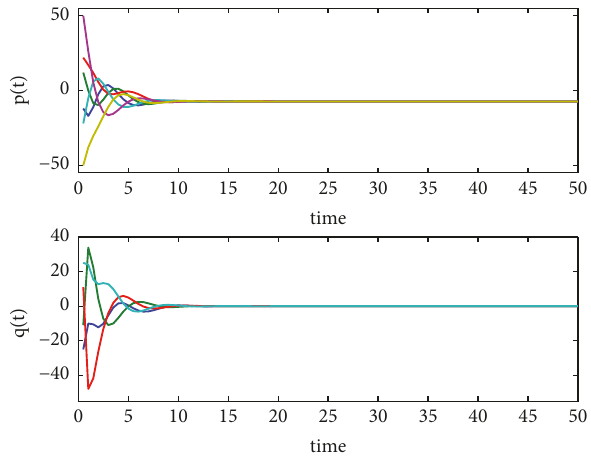
Figure 3: Agents’ state trajectories over network G 1 .